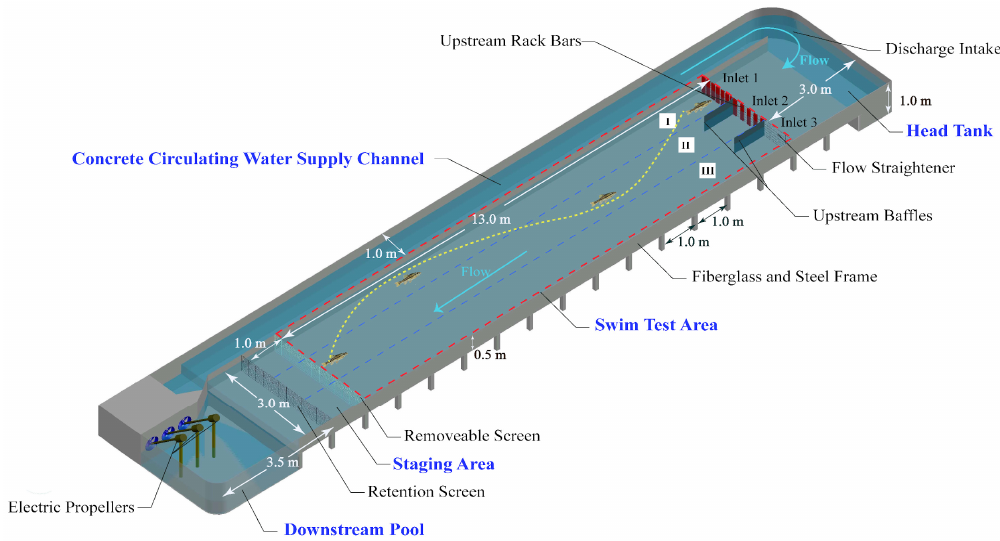
Figure 1. The geometric dimensions of the open-channel flume mainly including the head tank, swim test area, staging area, downstream pool, and concrete circulating water supply channel.